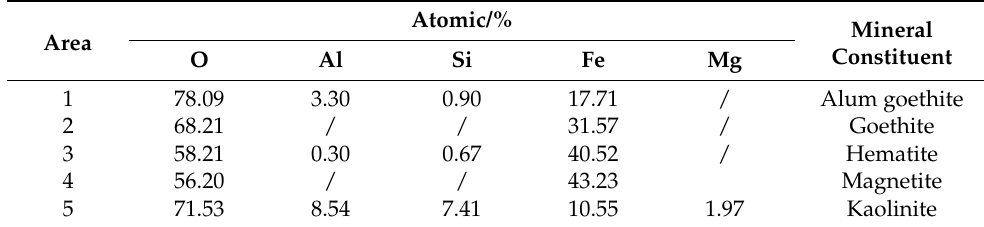
Table 6. EDS analysis results for areas in Figure